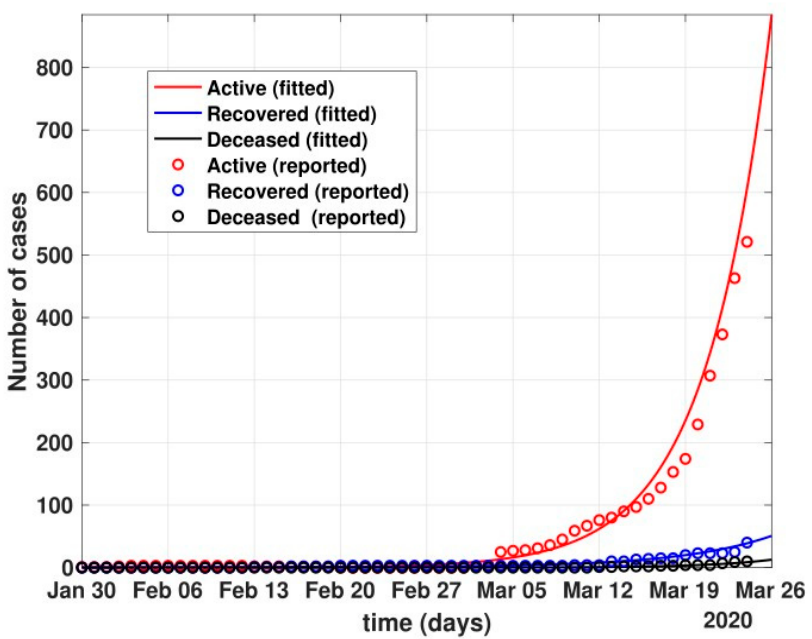
Figure 5. Fit of the proposed model (1) for the number of COVID-19 cases before lockdown, i.e., 24